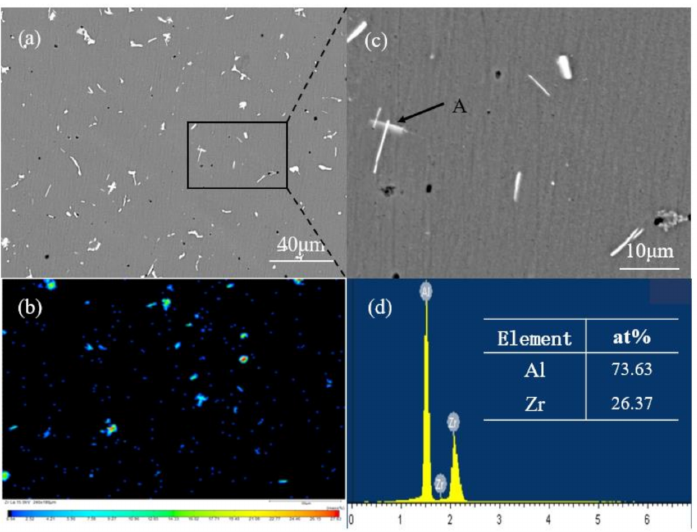
Figure 6. ( a,c ) The BSE images of alloy C after solution treatment; ( b ) The EPMA elemental map for Zr of alloy C after solution treatment; ( d )The EDS analysis result of point A.